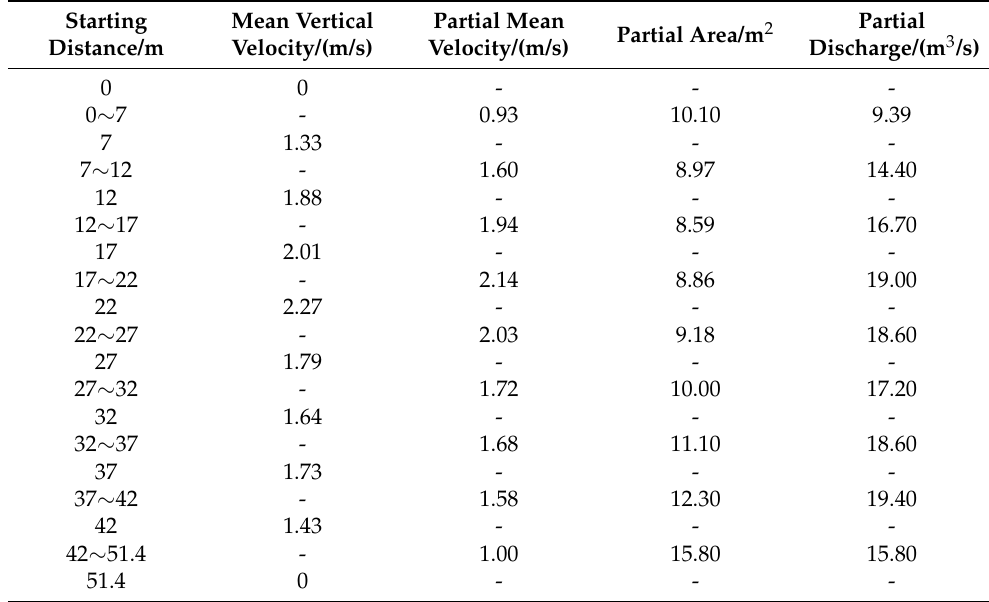
Table 5. Current meter measurement results of the comparison experiment.